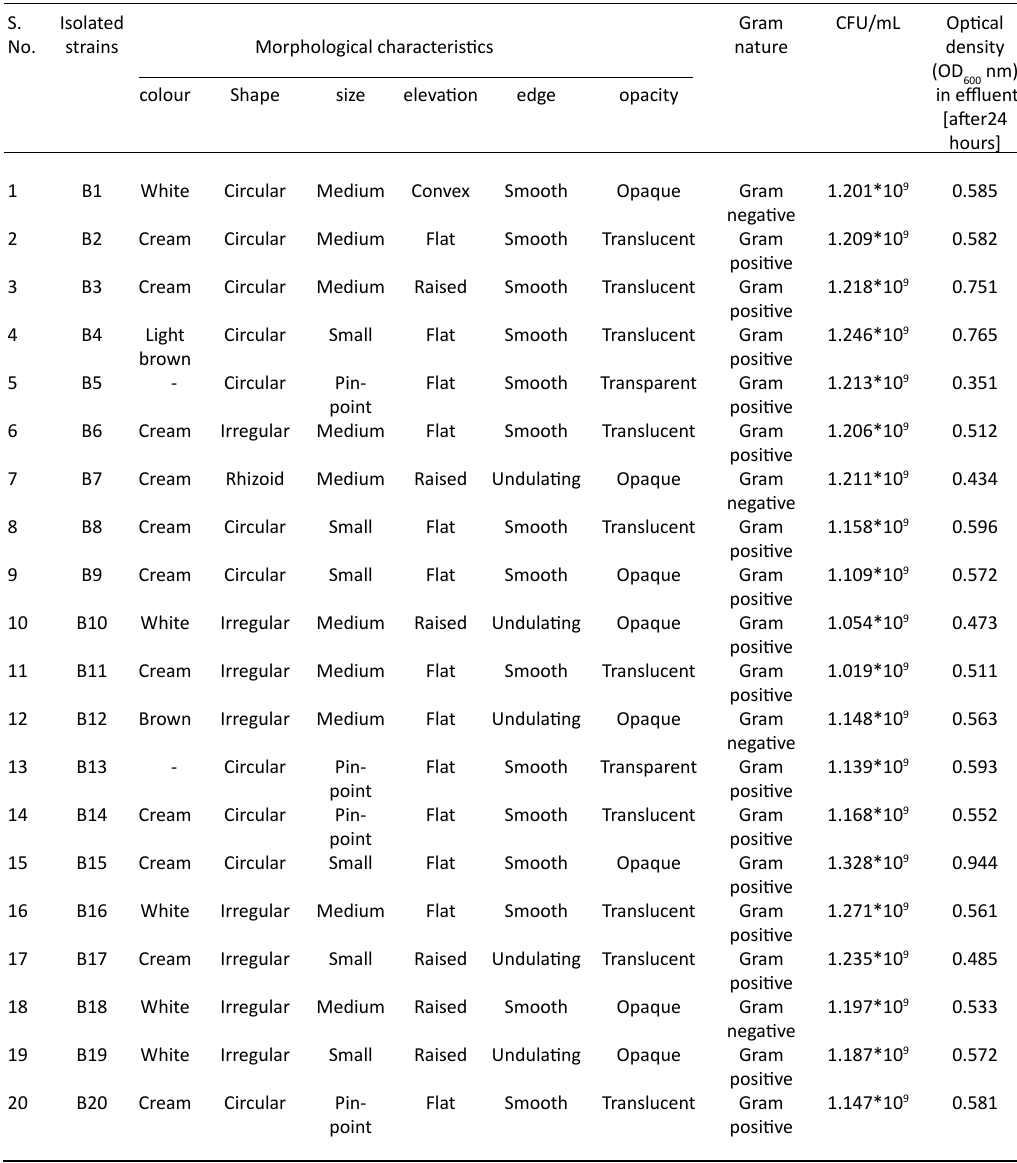
table 2. Morphological characteristics and growth parameters of the isolated bacteria S.